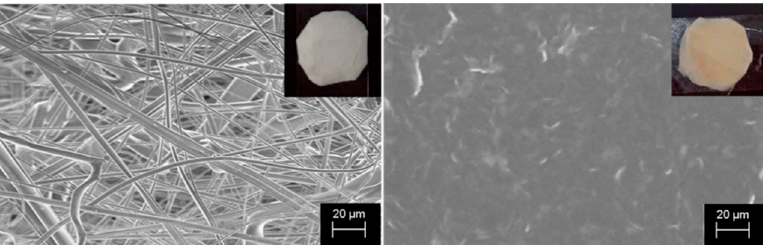
Figure 1. Photos and SEM images of polypropylene (PP) (on the left) and sulfonated pentablock copolymer (s-PBC)@PP (on the right) coupons.